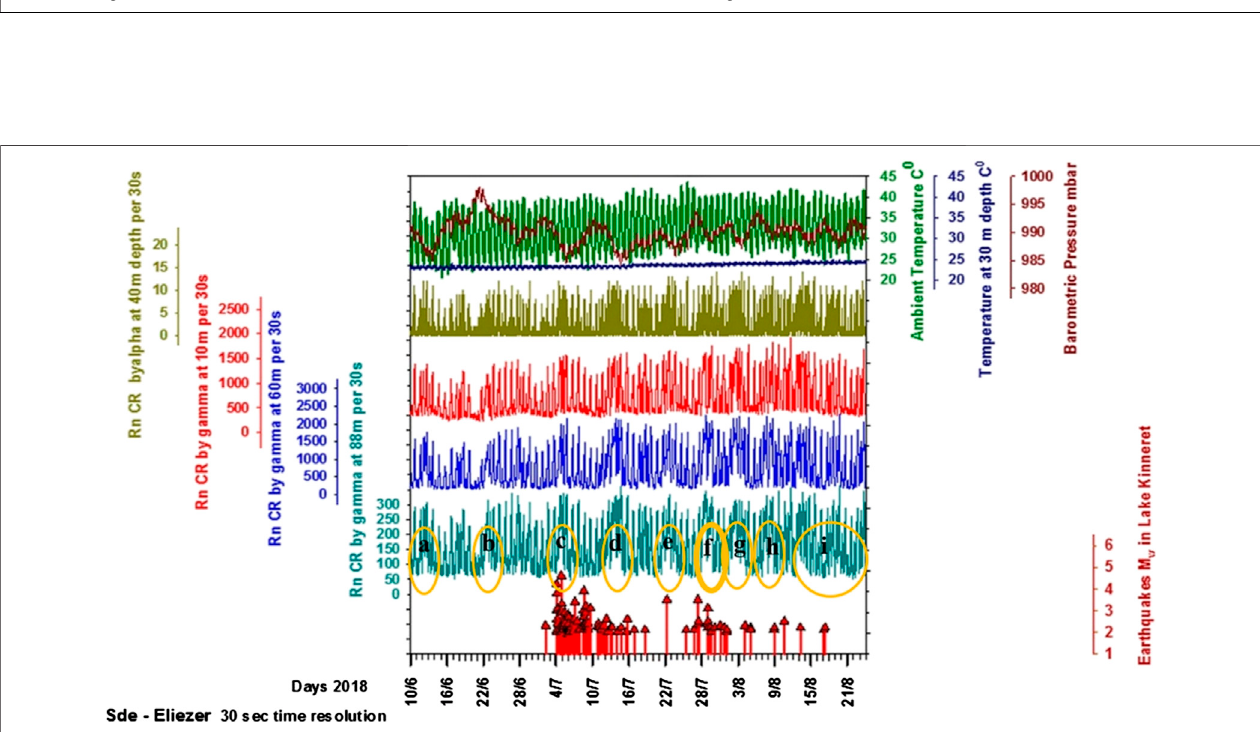
FIGURE 13 | (A) Accumulation of 103 earthquakes in the Dead Sea seismogenic active faults at the bottom of Lake Kinneret, which were recorded during the 2018 summer between 4 July and 18 August. (B) The tectonic map showing the internal structure of the lake (Hurwitz et al., 2002). EMF and WMF are the eastern and western marginal faults, KNF is the Kfar Nahum fault, and JF and AF are the Jordan and Almagor faults.